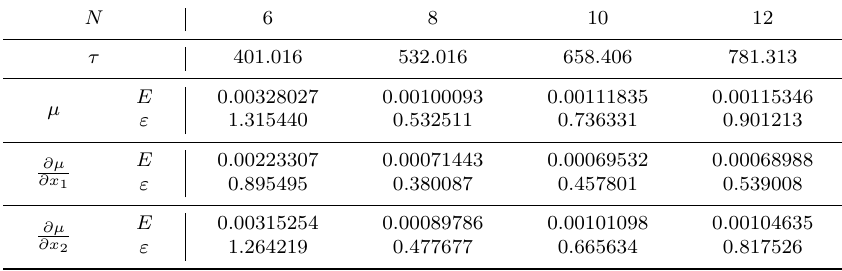
The total elapsed CPU time τ , the aggregate relative error E , the efficiency number ε = τE for Case 2.